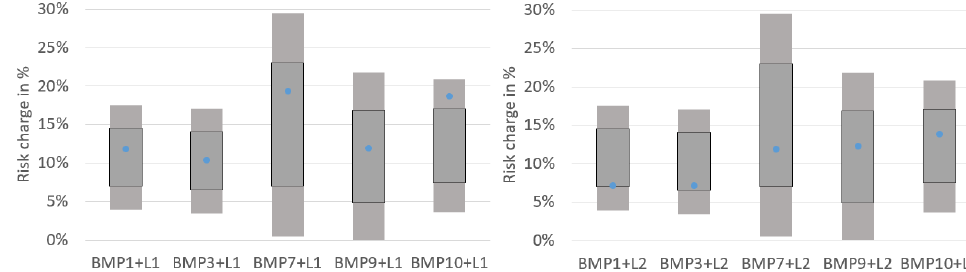
Figure 12. Comparison of the combined asset-liability benchmark portfolios; representation based on own results (blue dot) and EIOPA (2021a, p. 14) (gray